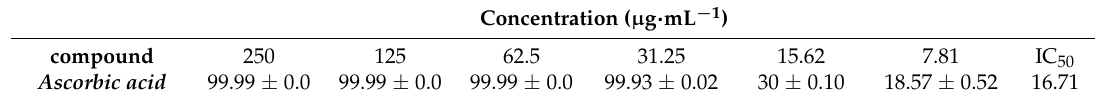
Table 12. Mortality of A. salina larvae at different concentrations of T. diversifolia essential oil.